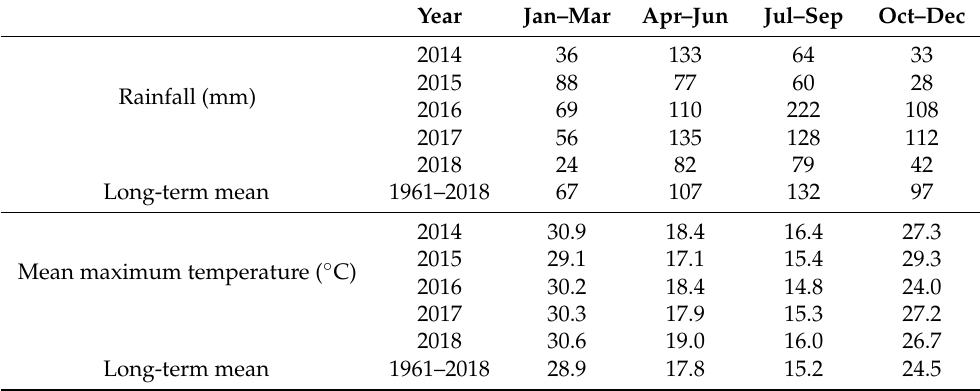
Table 1. Three-monthly annual rainfall (mm) and mean maximum temperature ( ◦ C) for the years 2014–2018 and three-monthly long-term mean rainfall (mm) and long-term mean maximum tempera- ture ( ◦ C) for the years 1961–2018 for the Wimmera region, South-Eastern